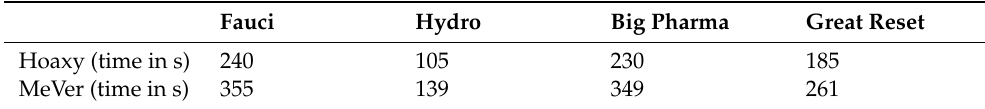
Table 11. Execution times of MeVer NetworkX analysis and visuazalion tool vs. Hoaxy for the four COVID-19-related use